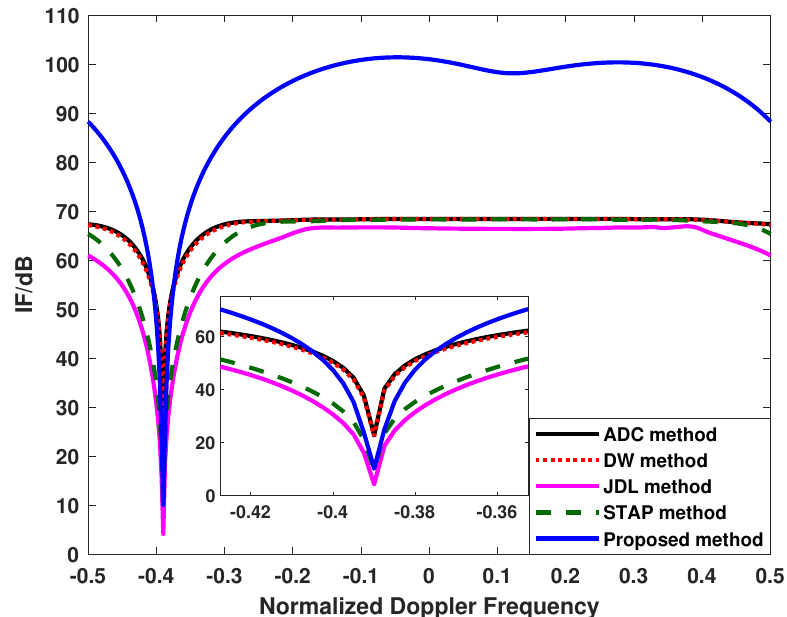
Figure 4. IF versus normalized Doppler frequency for non-side-looking